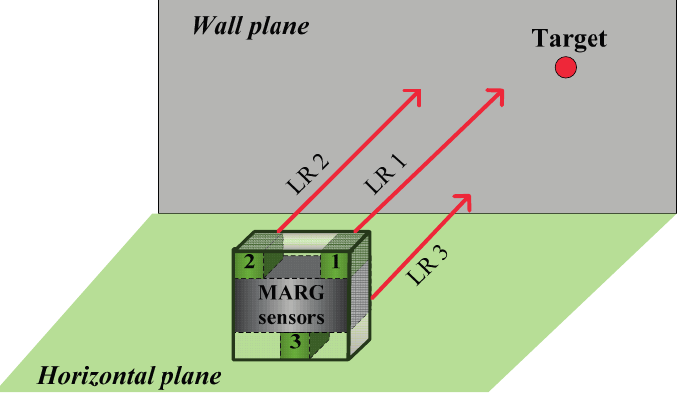
Figure 4. LR aiding system for attitude determination.